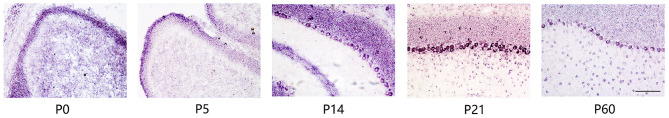
In situ hybridization results showing Ankfy1 mRNA expression in the murine cerebellum from postnatal day 0 (P0) to P60. Scale bars: 100 μm.